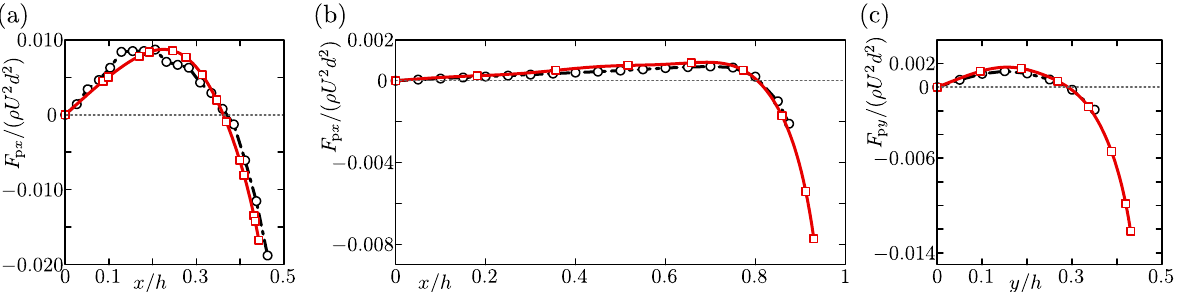
Figure 2. Profiles of the inertial lift force acting on a spherical particle located on the x -axis ( a , b ) and on the y -axis ( c ). The present results are shown by squares. The circles in ( a ) and ( b , c ) represent the profiles calculated by Di Carlo et al. [17] and Liu et al. [15], respectively. ( a ) A = 1, d / h = 0.22, and Re = 80, ( b , c ) A = 2, d / h = 0.1, and Re =